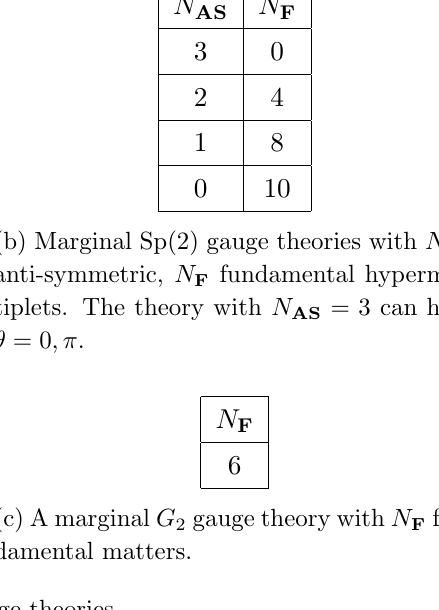
Table 1. Rank 2 gauge